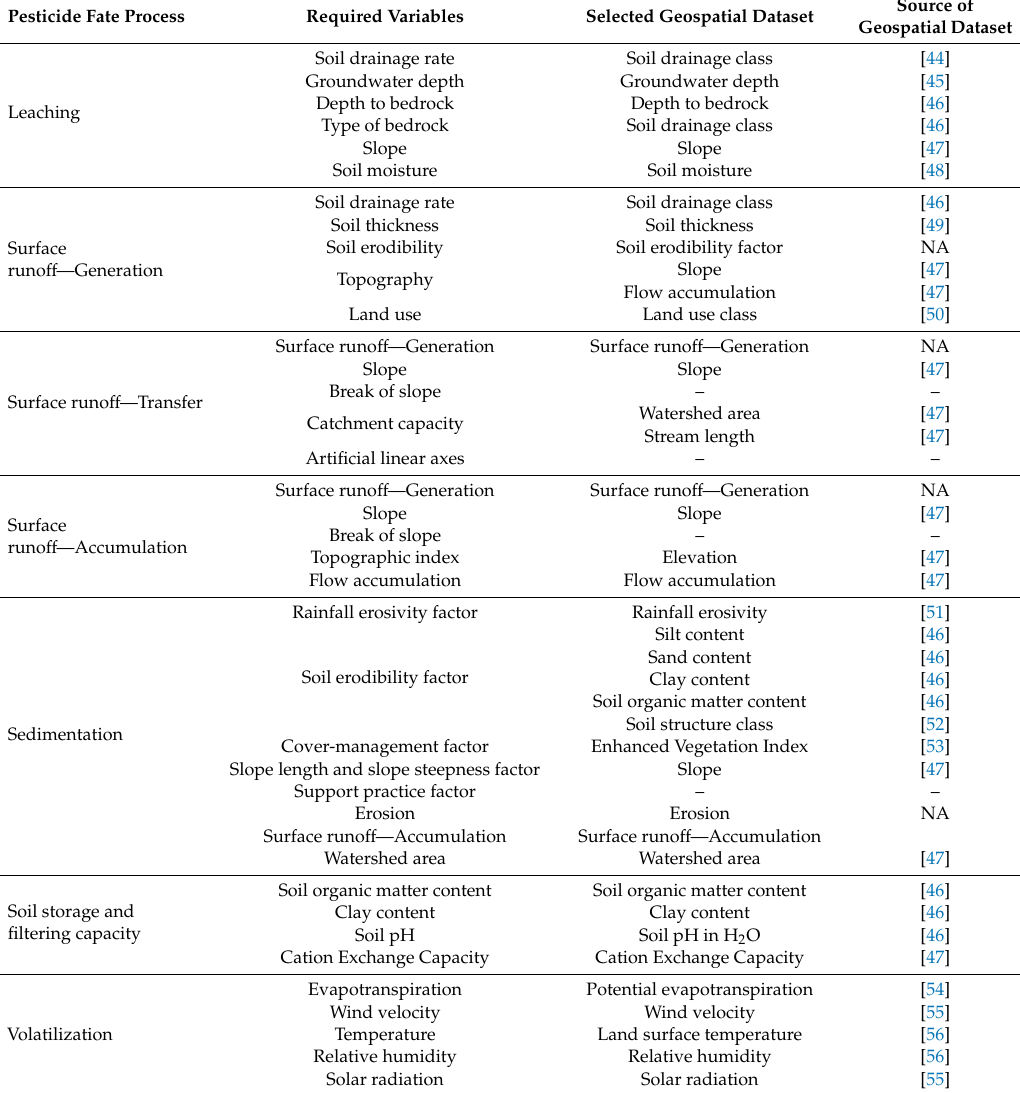
Table 2. The geospatial datasets that drive each key process, according to the scientific literature. The geospatial dataset selected by this study for each variable is listed together with the source details. “-“ indicates that no geospatial dataset was available for that variable. “NA” indicates that no source details are given because the dataset was generated by this